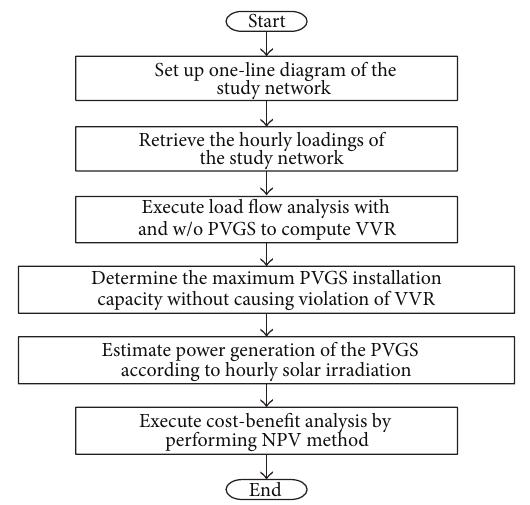
Figure 1: Flowchart of the proposed PVGS feasibility study method-